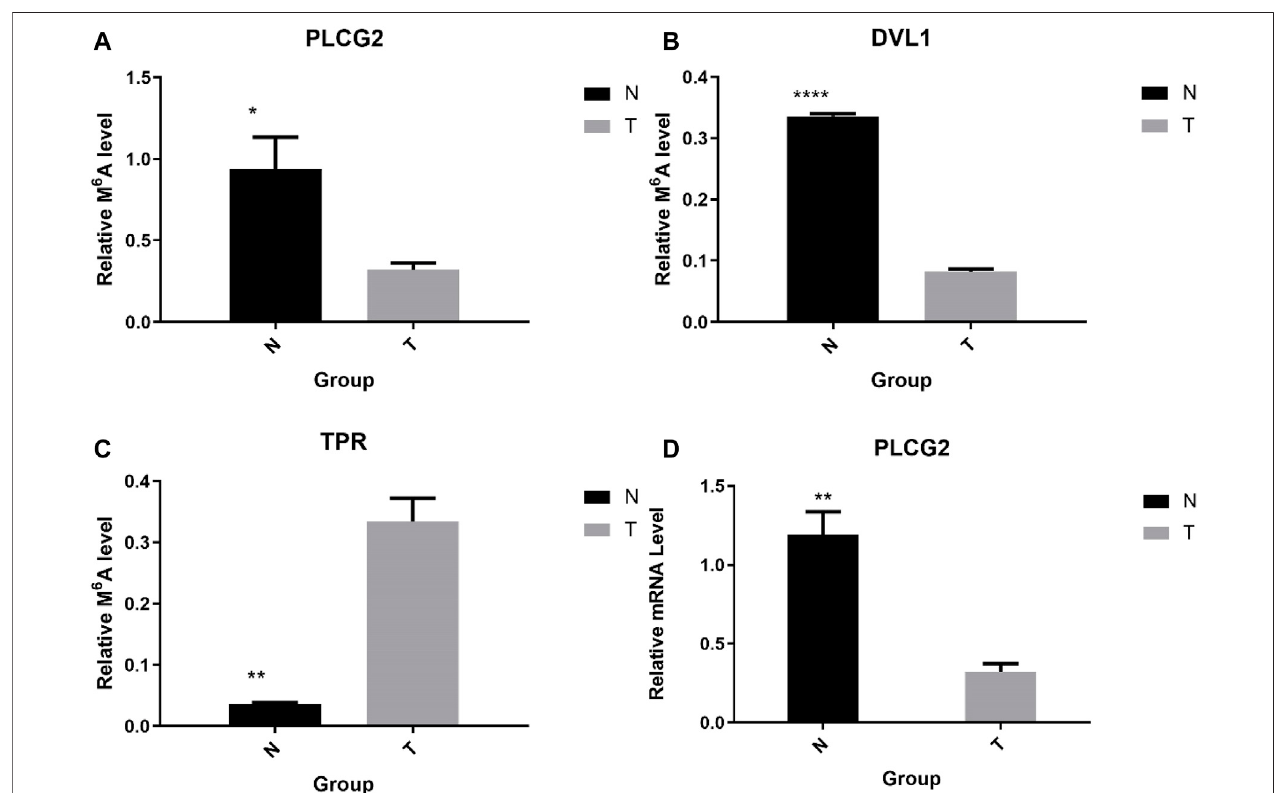
FIGURE 9 | Gene-speci fi c m 6 A qPCR assays and detection of global m 6 A levels. (A – C) Gene-speci fi c m 6 A qPCR validation of m 6 A level changes of three representative hyper-methylated or hypo-methylated genes in the normal control group and the AEG group samples. (D) Relative mRNA level of representative genes was measured by real-time PCR in normal control group and AEG group samples.